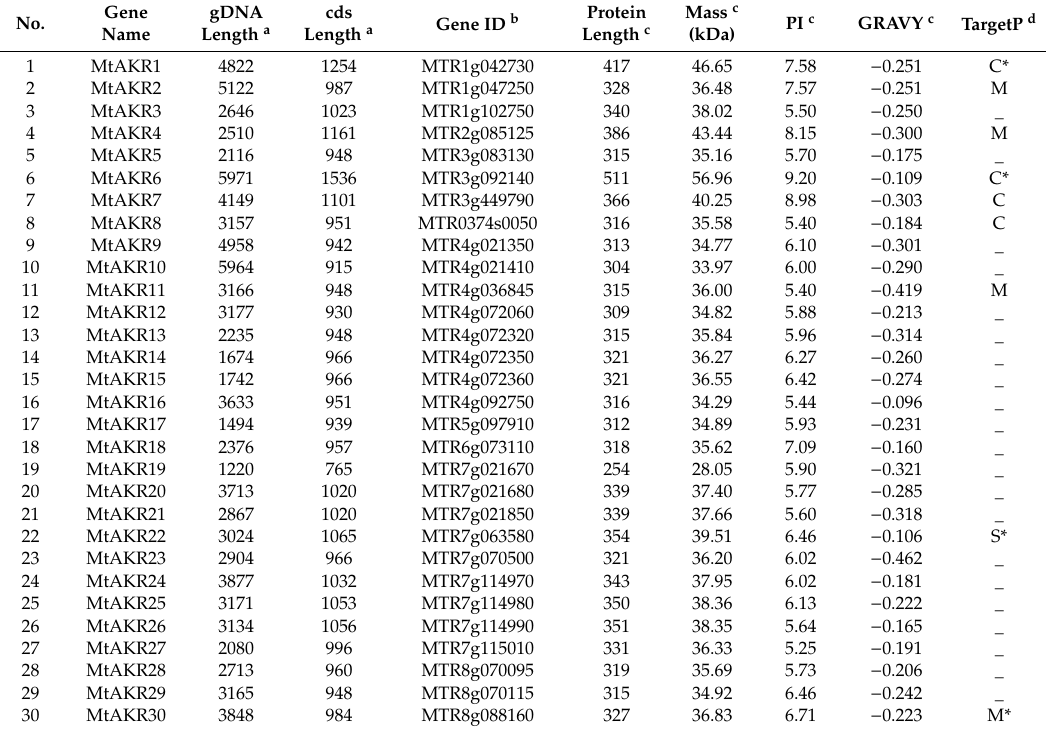
Table 1. The fundamental characteristics of candidate